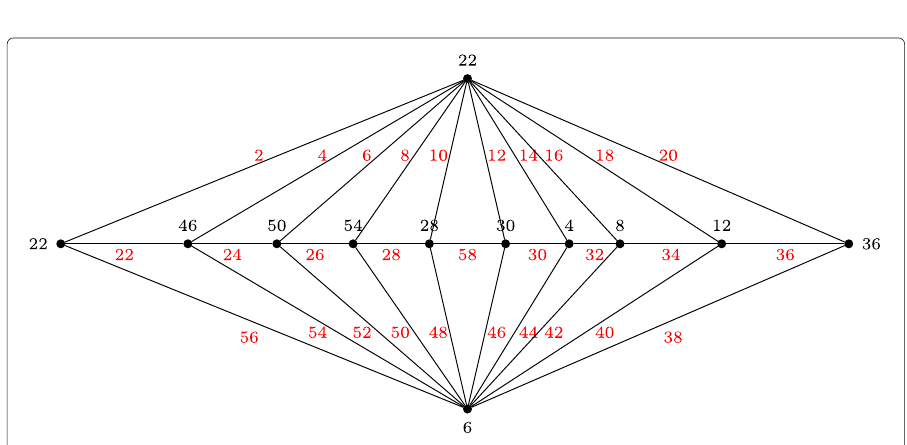
Fig. 11 Edge even graceful labeling of the double fan F